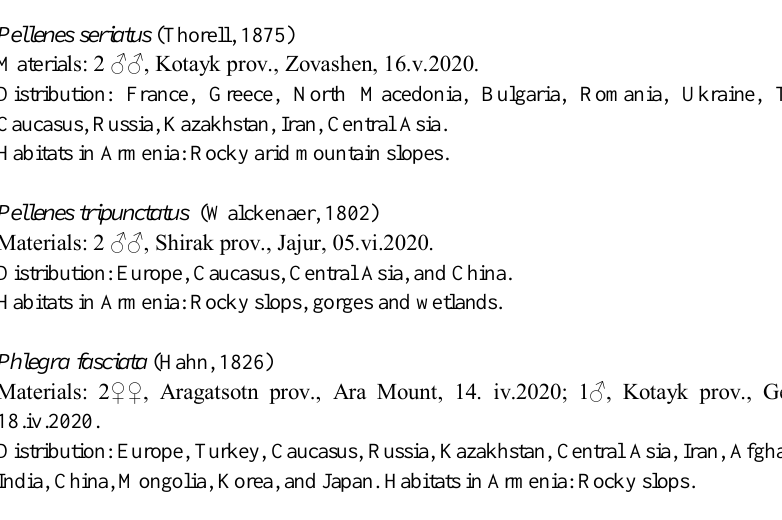
Table (2): Summary of checklist of Salticid species in Armenia.